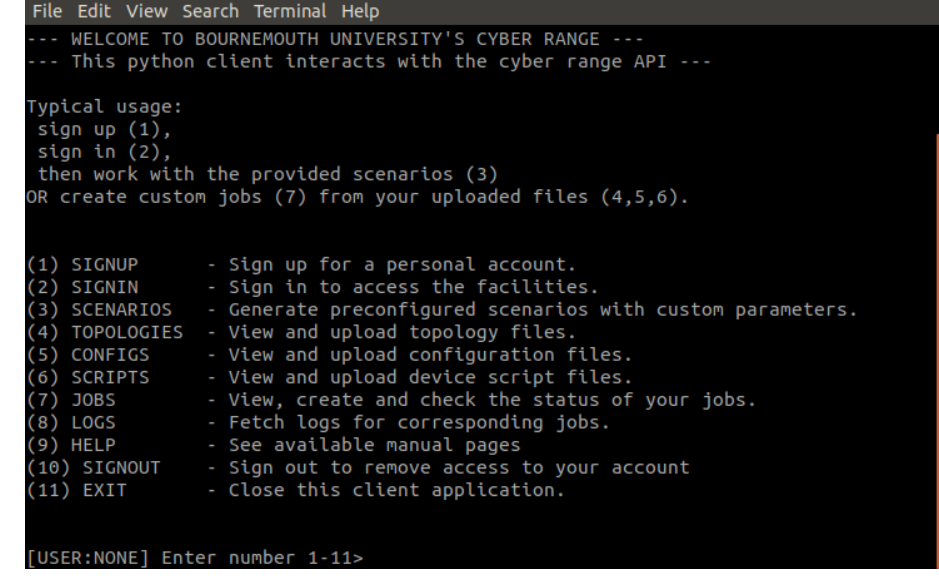
Figure 7. The home screen of the